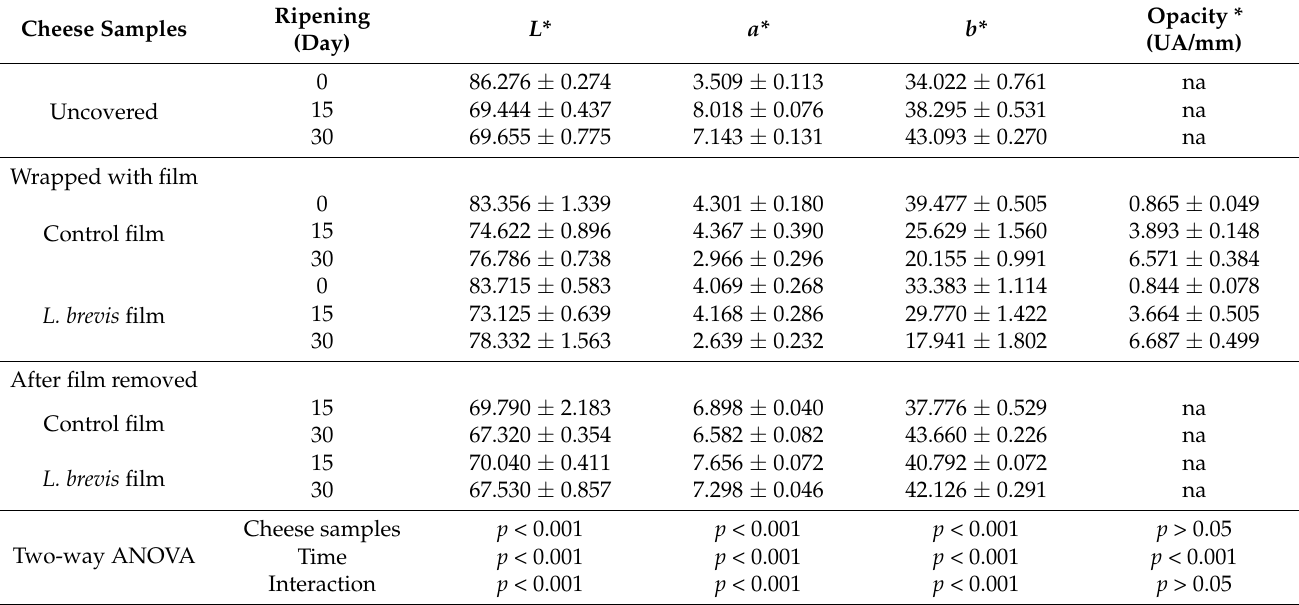
Table 3. Evaluation of film opacity and optical properties ( L *, a * and b *) of cheeses during maturation at 10 ◦ C for 30 days. Optical properties of cheeses are presented without film (uncovered), wrapped with control film, wrapped with L. brevis SJC120 films, and after removing of films. Values are the mean ± SEM ( n =